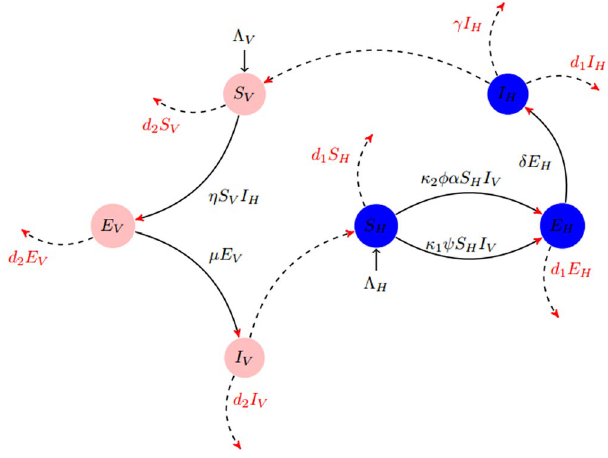
Figure 1. Flow chart for the transmission for the Pine wilt disease